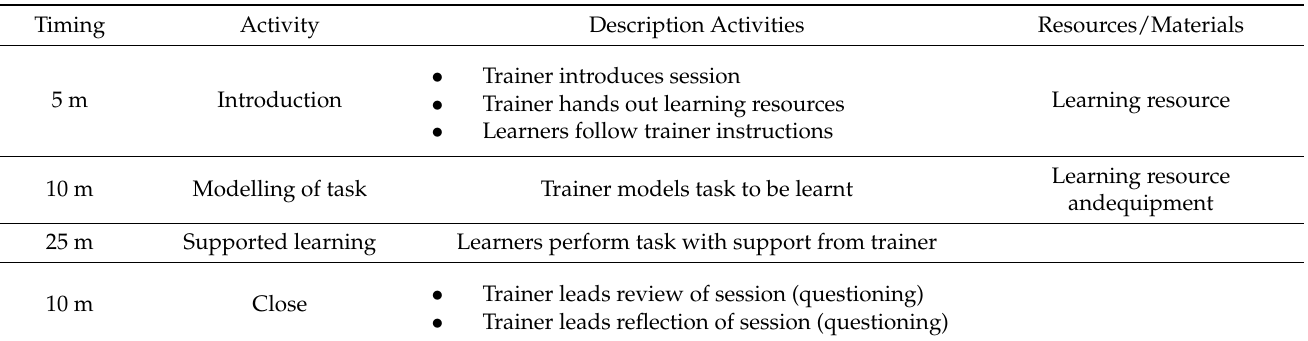
Table 1. Training session plan.